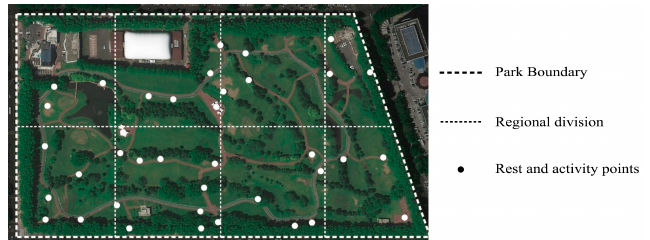
Figure 2. Regional division and rest facilities distribution map.